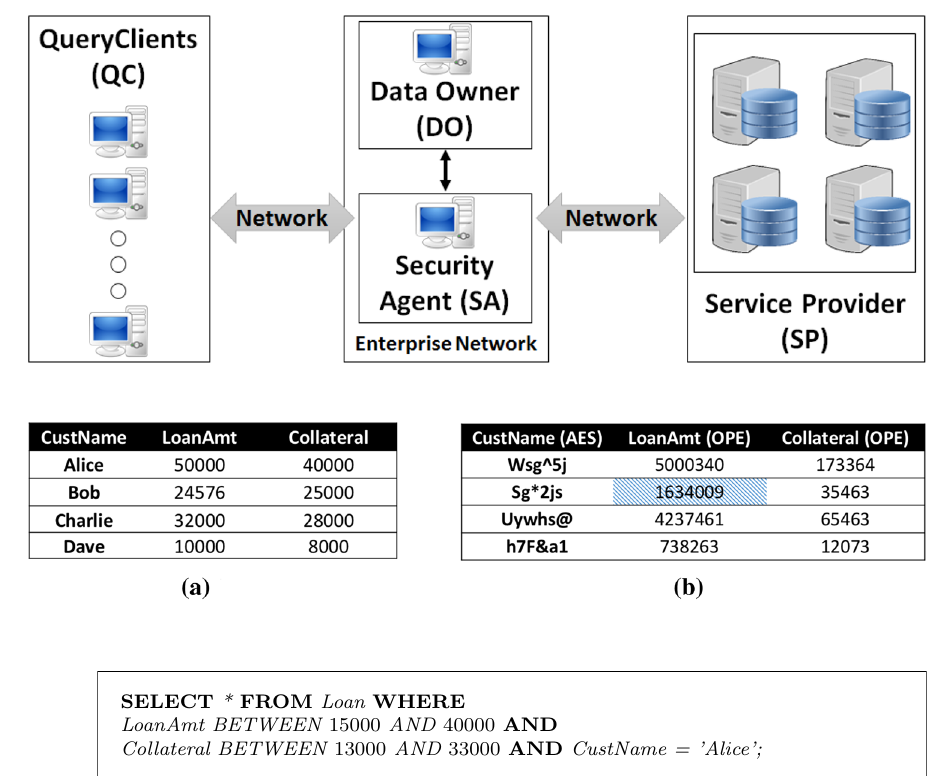
Fig. 3 Form-based SQL query with range predicates SELECT * FROM Loan WHERE LoanAmt BETWEEN 15000 AND 40000 AND Collateral BETWEEN 13000 AND 33000 AND CustName =